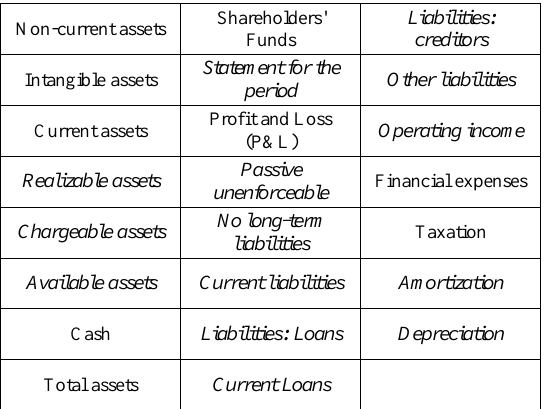
Table 4. The 23 econometric variables.